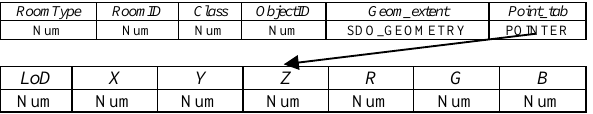
Figure 6. Schema of the S3DIS nested table, S3OBJ_NEST, containing a base table and many sub